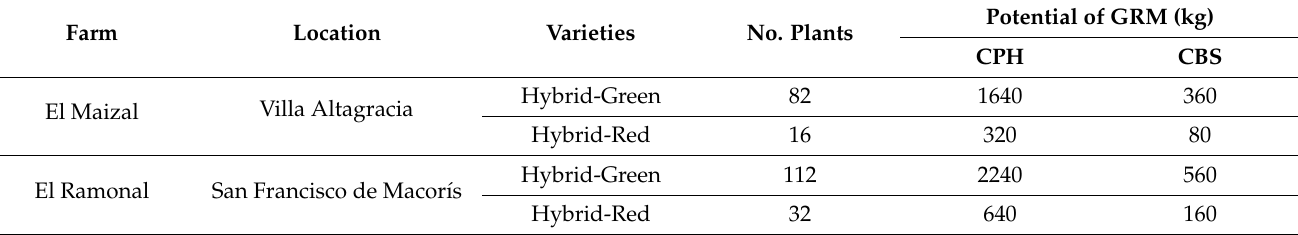
Table 2. Selection of farms for collecting cocoa green raw